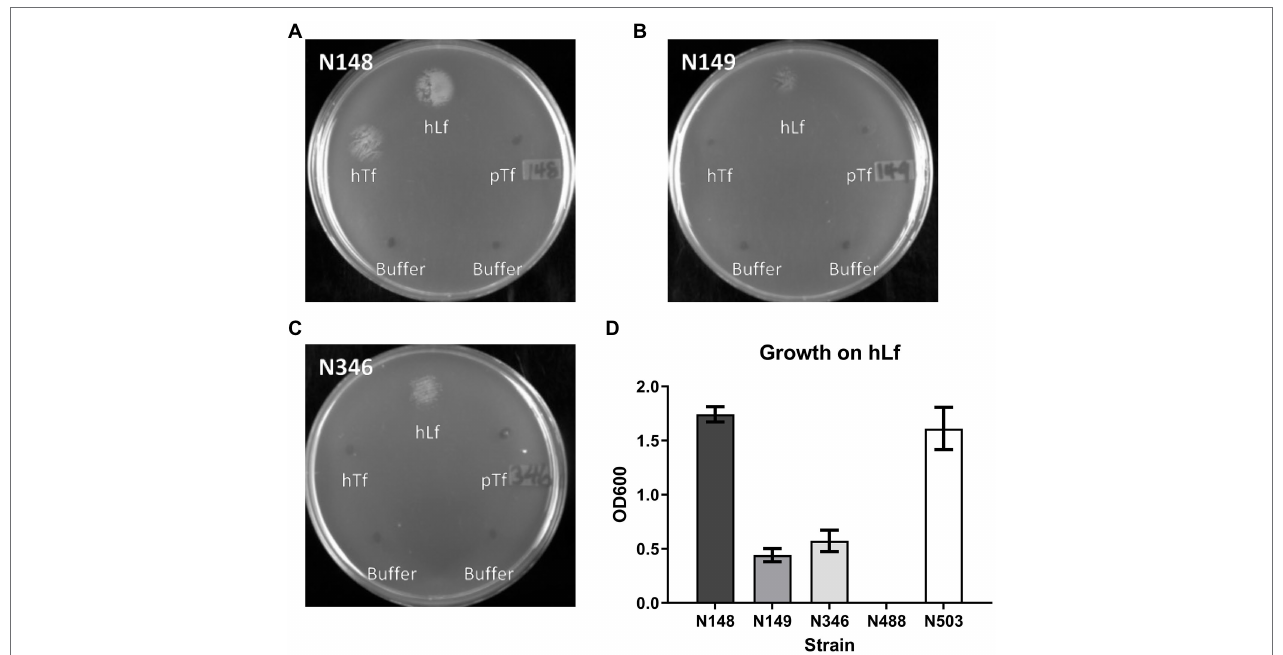
FIGURE 4 | Growth of wild type and CopB mutant strains on transferrin and lactoferrin as sole iron source. Moraxella catarrhalis strain wild type (N148) (Panel A ), insertional copB mutant (N149) (Panel B ), and Δ copB mutant ( copB gene completely removed – N346) (Panel C ) were plated onto BHI agar with 50 μ g/ml Desferal. Five microliters of buffer alone or containing 3.1 nmol of hTf, hLf or pTf was spotted onto the plate prior to incubating overnight for growth. OD600 quantification of bacterial growth on hLf from the plate assay (Panel D ) in strains N148, N149, N346, Δ copB Δ lbpA mutant (N488), and Δ copB mutant complemented with wild type copB gene (N503). Results are presented as mean ± SEM. Each bar represents six replicates.